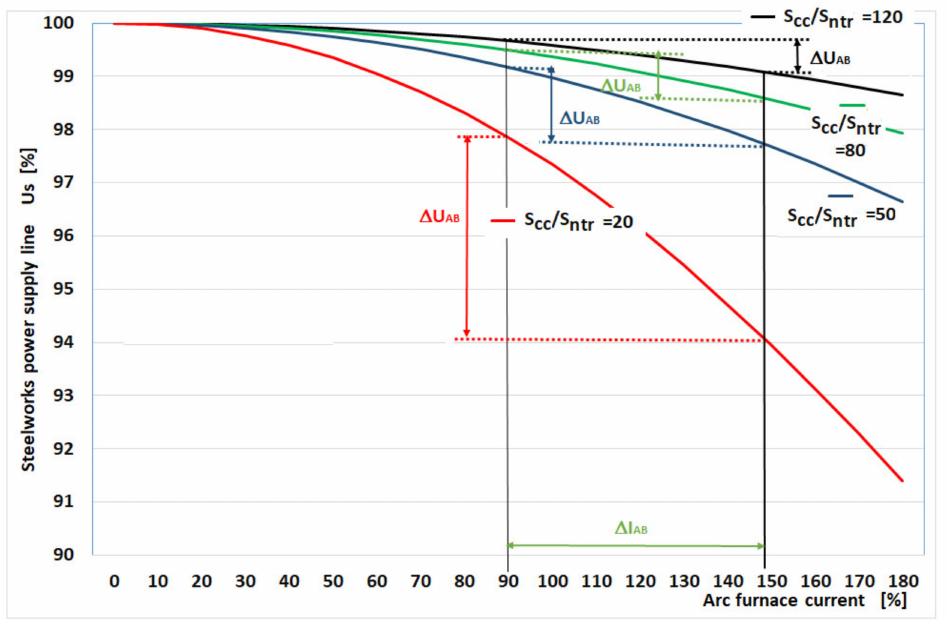
Figure 9. Voltage change as a function of current changes the furnace without the resistance in the power supply circuit of an electric arc.